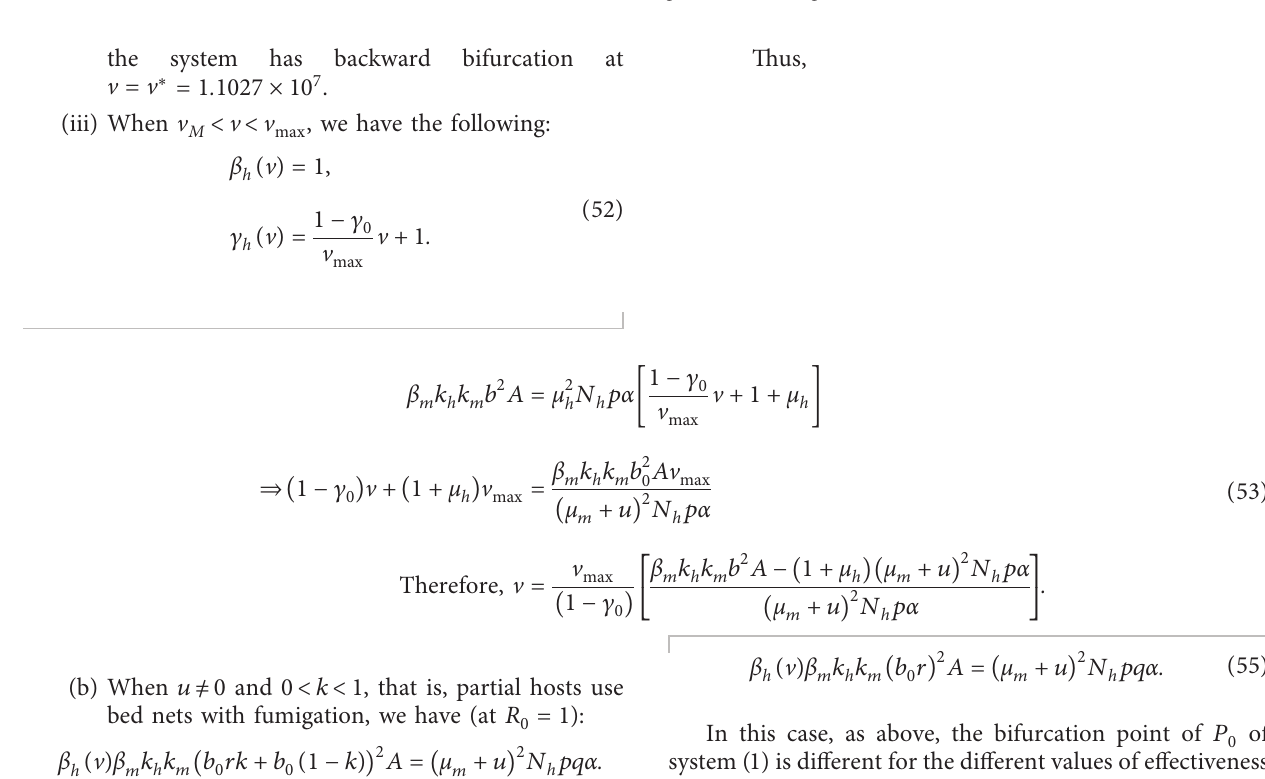
Figure 11: Bifurcation diagram with